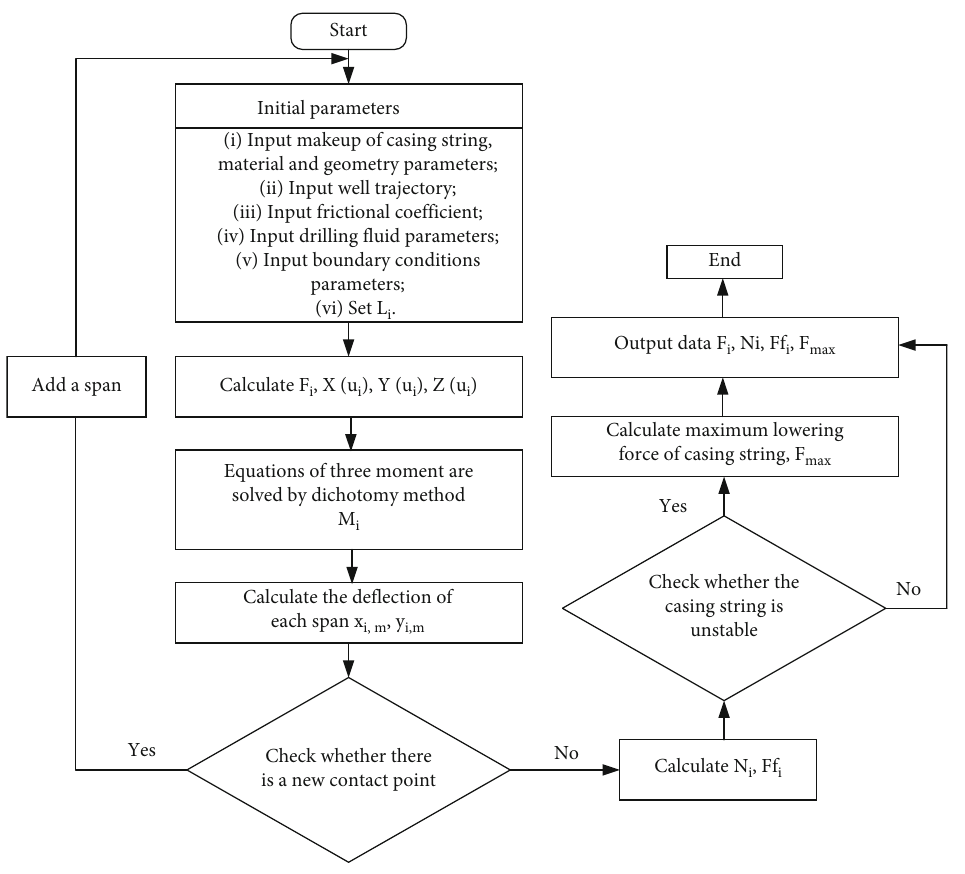
Figure 4: Flowchart of the solution